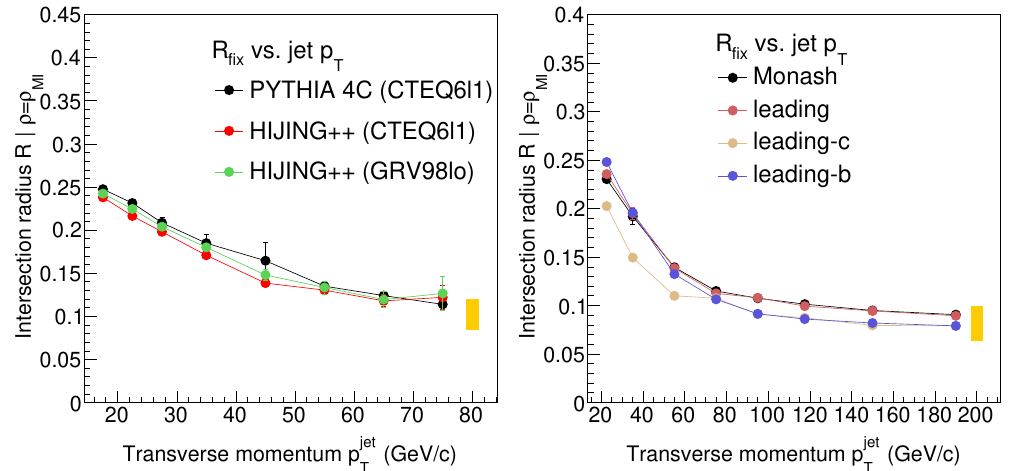
Figure 7. ( Left ) The p jet dependence of R fix for the P YTHIA 4C tune is compared with H IJING ++; T ( Right ) Comparison of different jet selections for the P YTHIA Monash